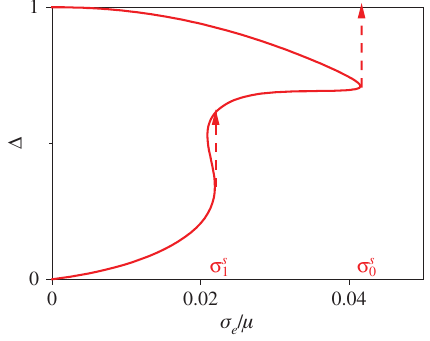
Figure 5 Dependence of relative part of moved sites on external stress. Arrows show the changes in Δ ( σ